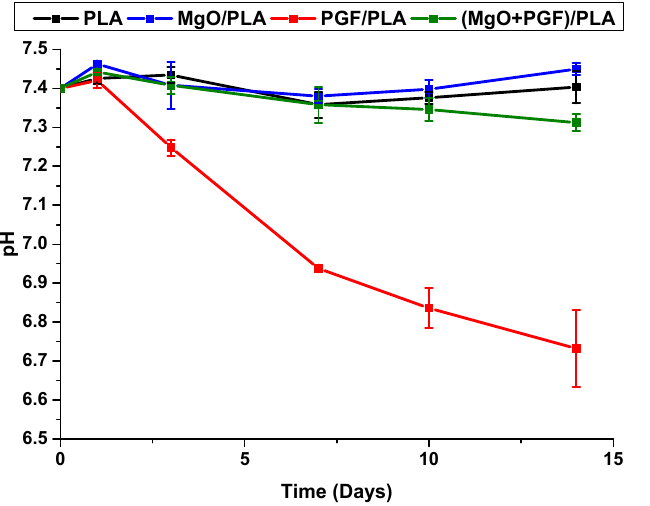
Figure 11. pH profile of the Tris-HCl immersed with different scaffolds during 14 days of in vitro degradation.